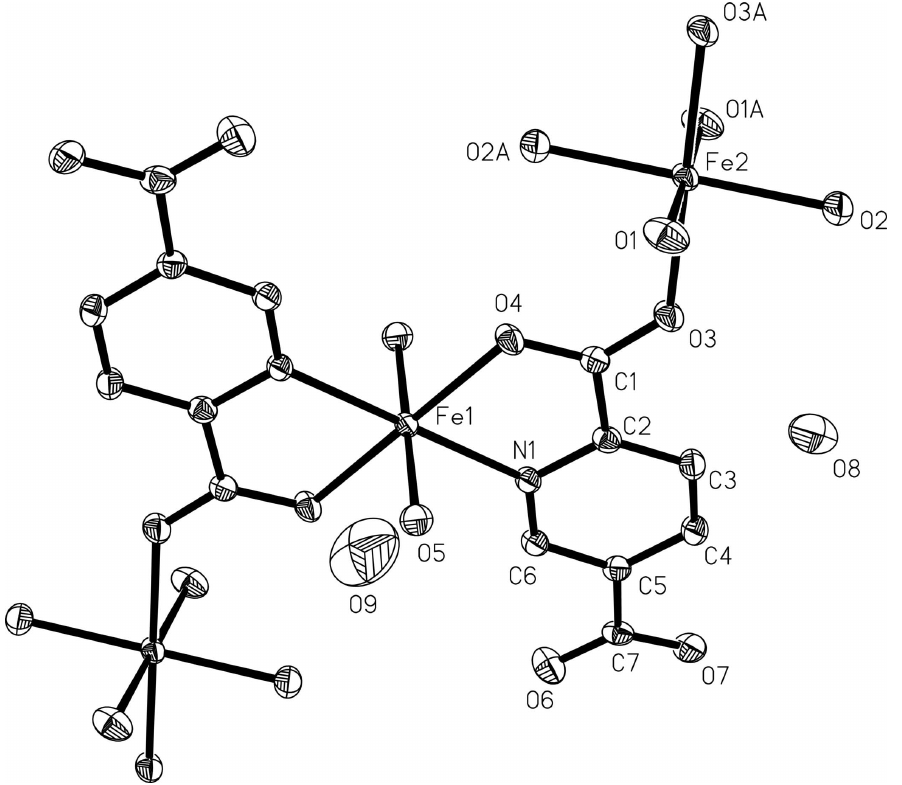
Part of the polymeric structure of the title compound, showing 30% probability displacement ellipsoids and the atom- numbering scheme. The H atoms are omitted for clarity. The suffix A corresponds to symmetry code (2 - x , 1 - y , 1 - z